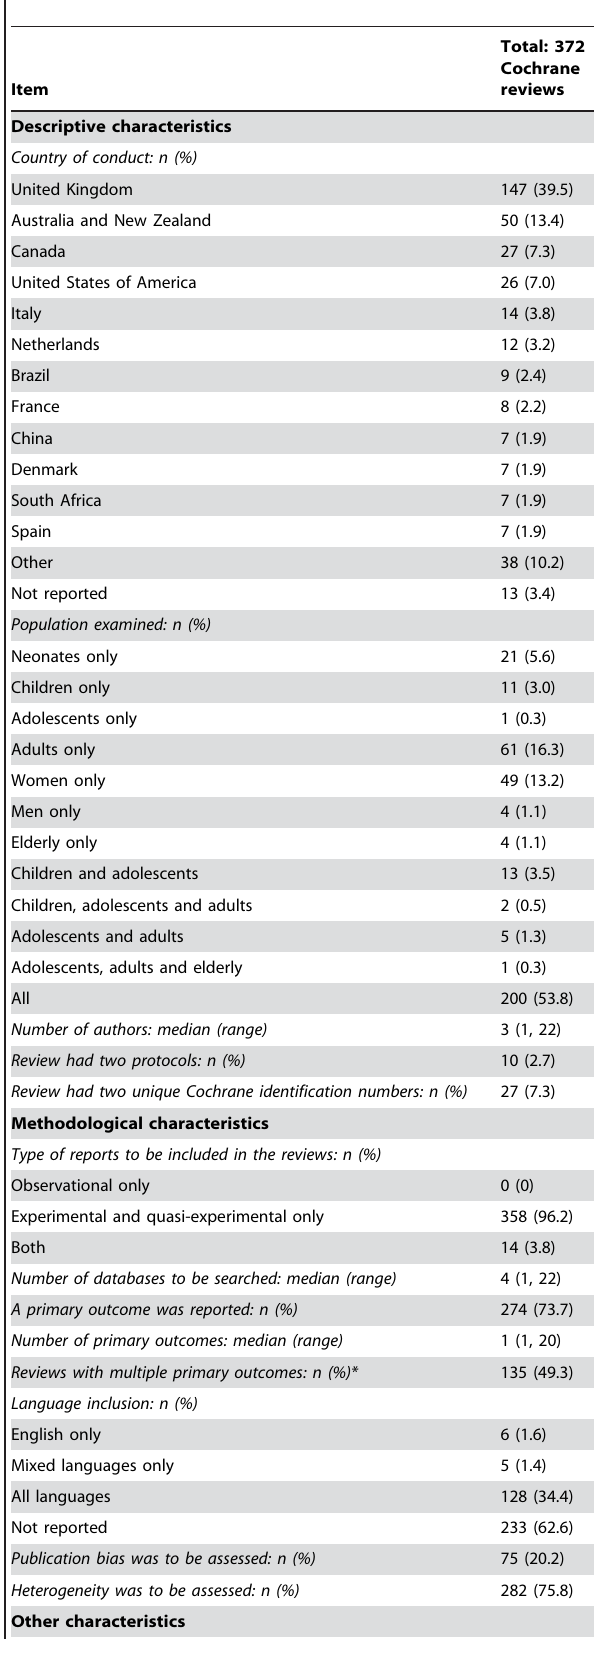
Table 1. Cochrane review characteristics.